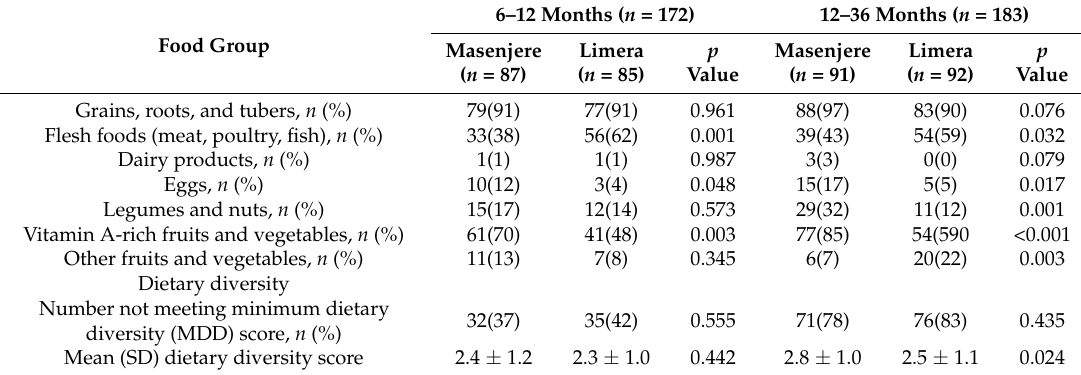
Table 3. Comparison of the dietary diversity of 6–36-months-old children from Masenjere and